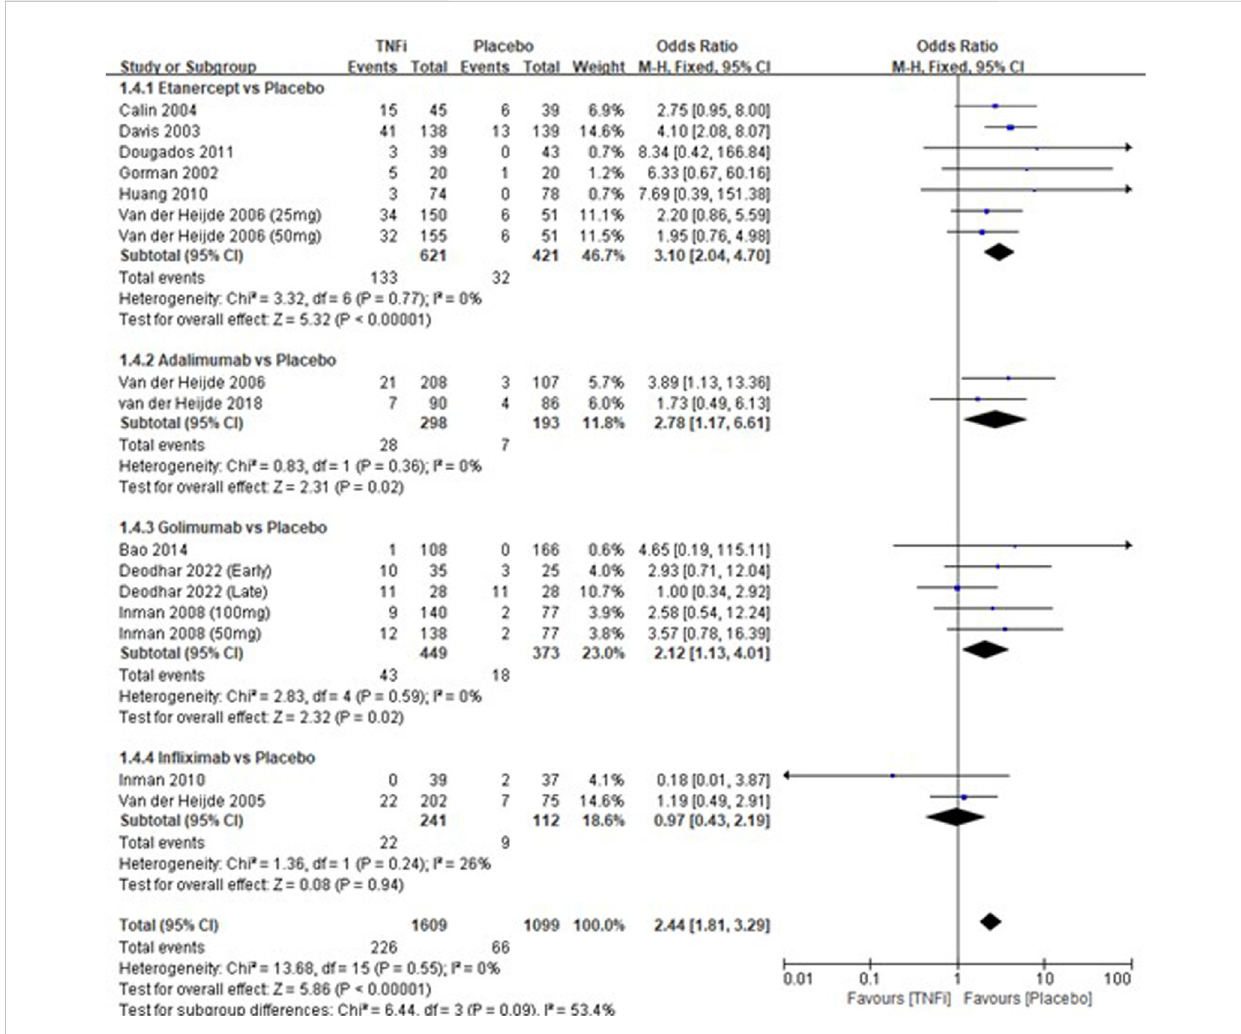
FIGURE 5 Pooled estimate of the incidence of injection-site reactions between TNFi and placebo groups in patients with ankylosing spondylitis. The odds ratio > 1.0indicatesthattheincidenceofinjection-sitereactionsishigherintheTNFigroupthanthatintheplacebogroup.Thesubheading “ Events ” refers to the number of injection-site reactions. “ Total ” refers to the total number of individuals. CI, con fi dence interval; df, degrees of freedom; M-H, Mantel – Haenszel method of